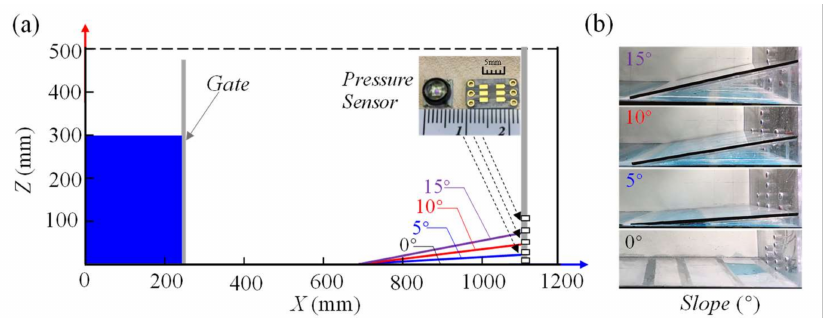
Figure 2. Experimental setup: ( a ) apparatus system with side wall equipped with Honeywell Pressure Transducers (HPTs); ( b ) locations of HPTs and the 4 bed slopes employed: 0-degree, 5-degree, 10-degree, 15-degree.